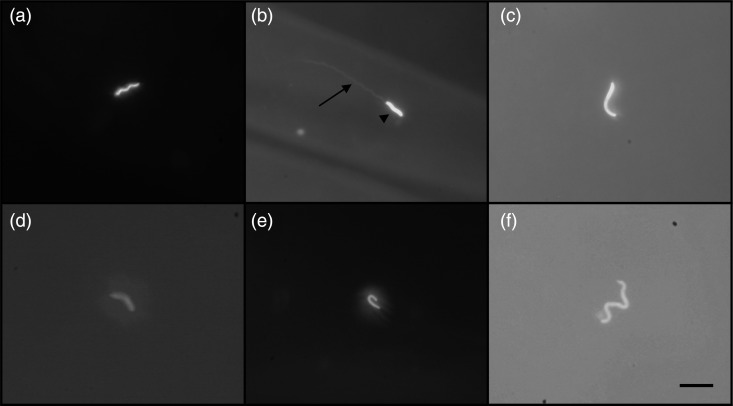
Sperm bound on perivitelline membranes stained with Hoechst 33342. (a) Hawaiian crow (Corvus hawaiiensis). (b) Finch-billed myna (Scissirostrum dubium). (c) Northern brown kiwi (Apteryx mantelli). (d) Storm's stork (Ciconia stormi). (e) Collared kingfisher (Todiramphus chloris). (f) Green-naped pheasant pigeon (Otidiphaps nobilis nobilis). Arrowhead indicates sperm head; arrow, sperm tail. Bar represents 10 μm.